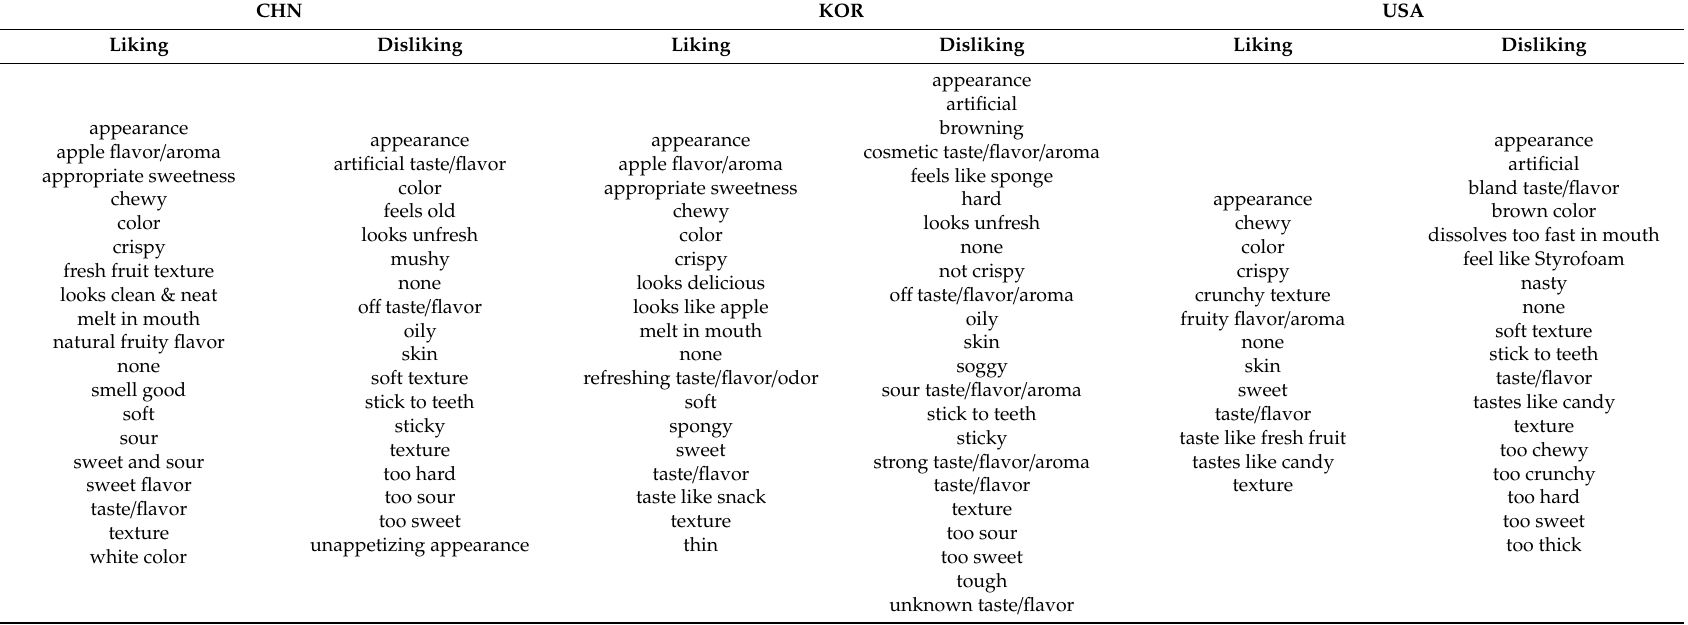
Table 5. Liking and disliking terms selected by more than 10% of the Chinese, Korean, and US